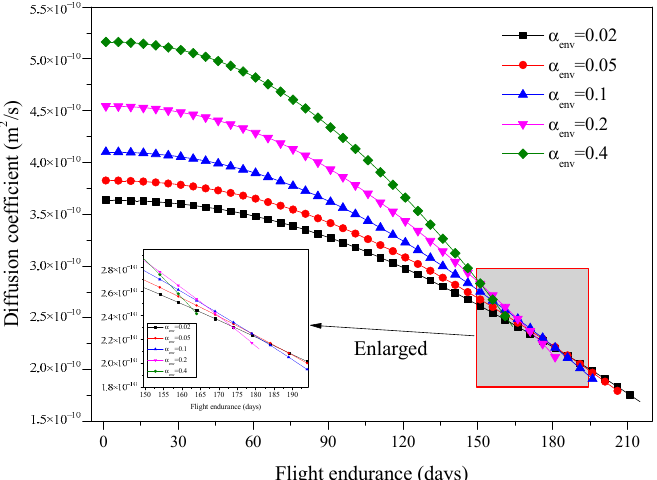
Figure 15. Effects of envelope absorptivity on the diffusion coefficient.